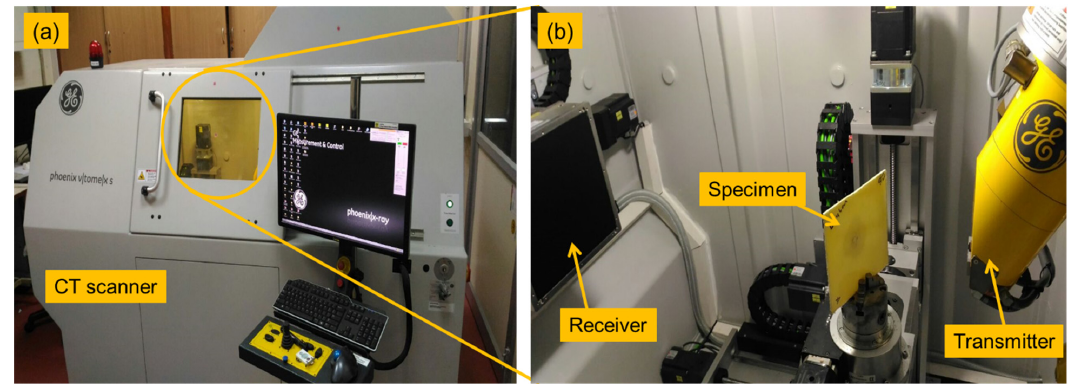
Figure 3. C-scan analysis instrument for high-velocity impact test. ( a ) CT scan machine used and ( b ) impact tested composite laminate subjected to analysis .